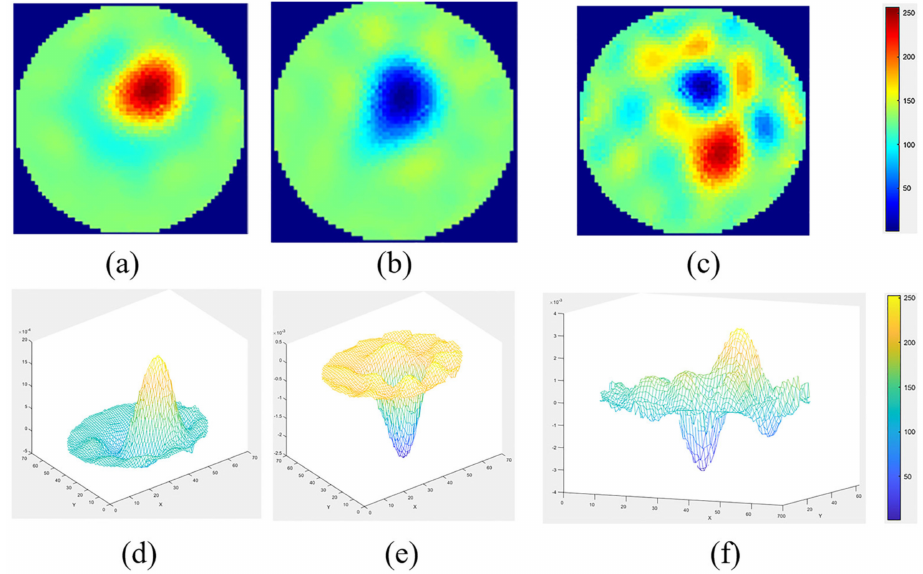
Figure 14. Reconstructed images and 3D surface mesh of ( a , d ) plastic stirrer, ( b , e ) metallic stirrer, and ( c , f ) plastic and metal stirrer